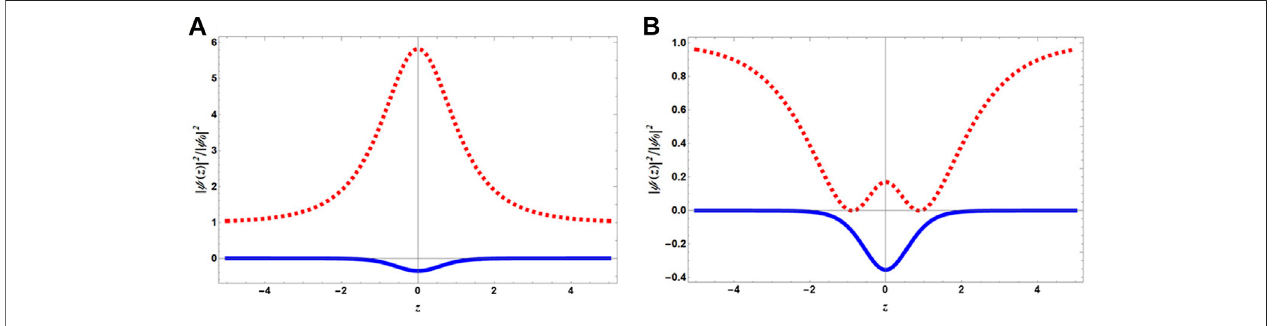
FIGURE 5 | (Color Online) Density pro fi les of Eq. 24 and their potential landscape. (A) Red dashed line depicts the bright soliton-like pro fi le. (B) Red dashed line represents w -soliton. In both the fi gures, blue solid line represents their potential landscape δ ( z )/ δ 0 . The fi gure is normalized by ψ 0 = β /2 γ , and we fi nd that δ 0 (cid:2) − β 3 γ 2